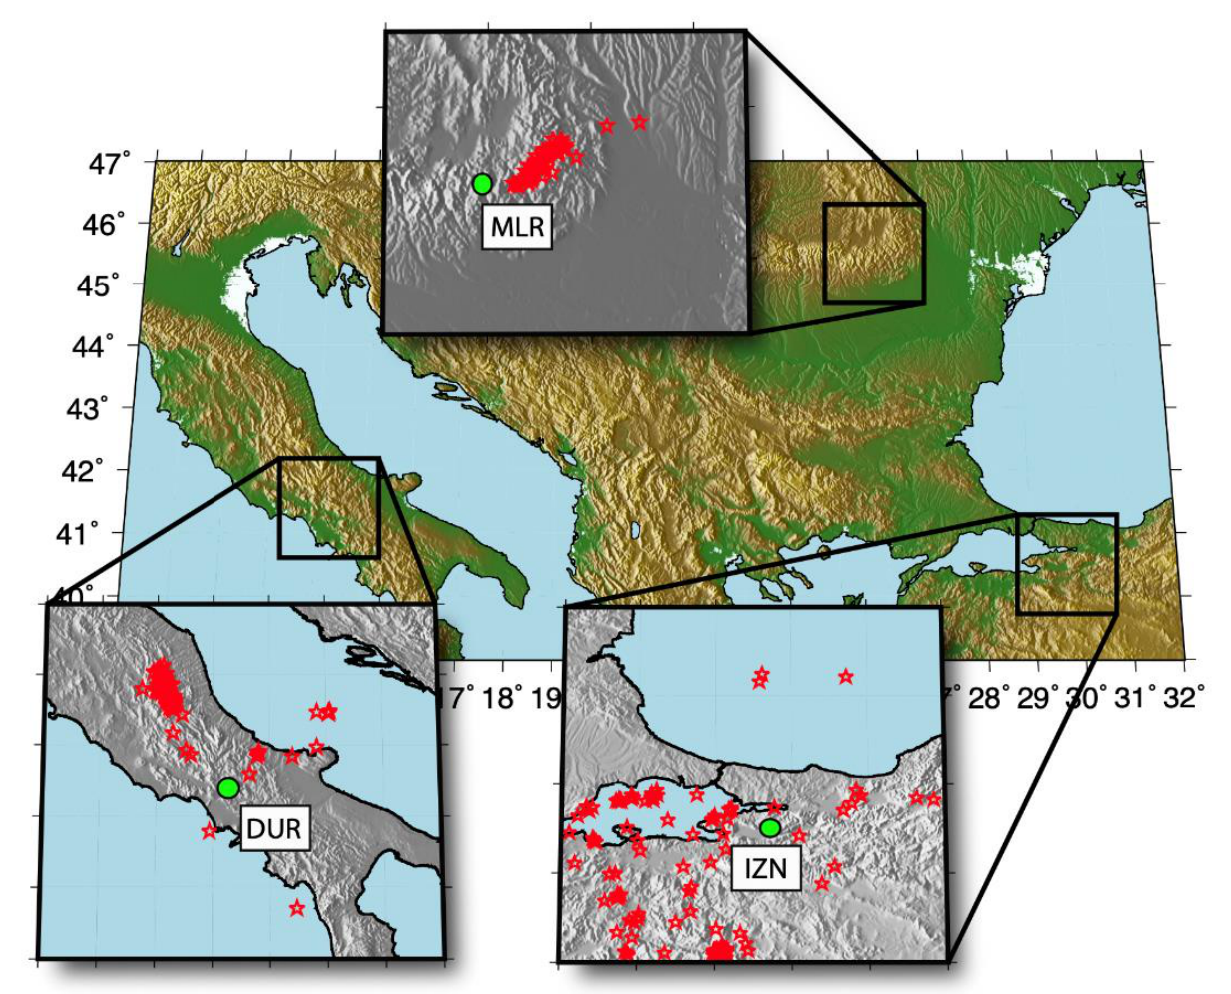
Figure 1. Topographic map of Southern Europe showing locations of geomagnetic observatories (green circles) and nearby earthquakes of Mw > 4 (red stars) that might be expected to generate near-field electromagnetic emissions detectable on the geomagnetic field. Abbreviations: DUR—Duronia (Italy), IZN—Iznik (Türkiye), MLR—Muntele Rosu (Romania). The overlapped magnetic and